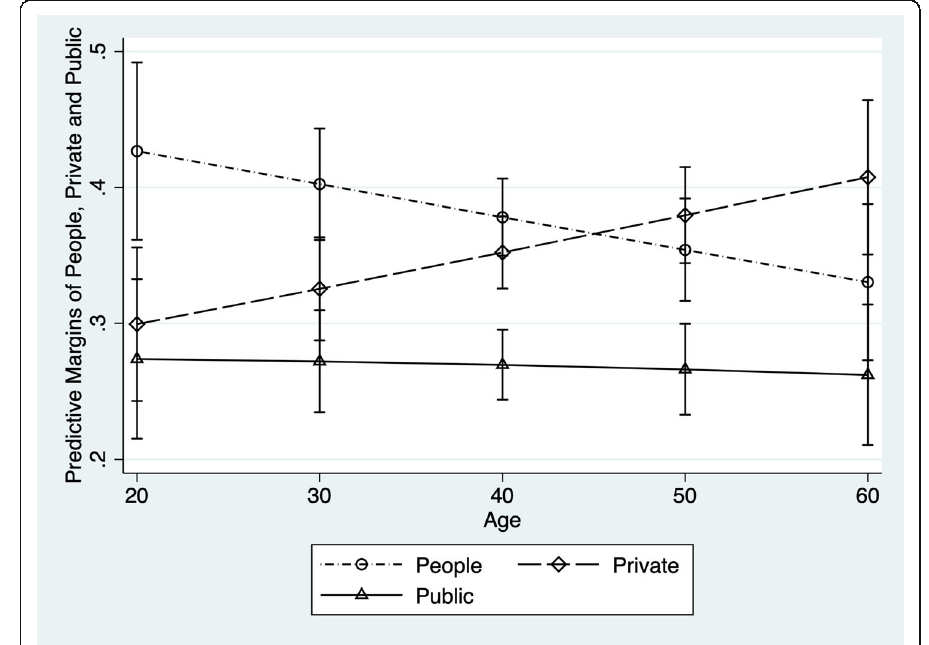
Fig. 6 Predictive margins of Laying down the foundations of home by